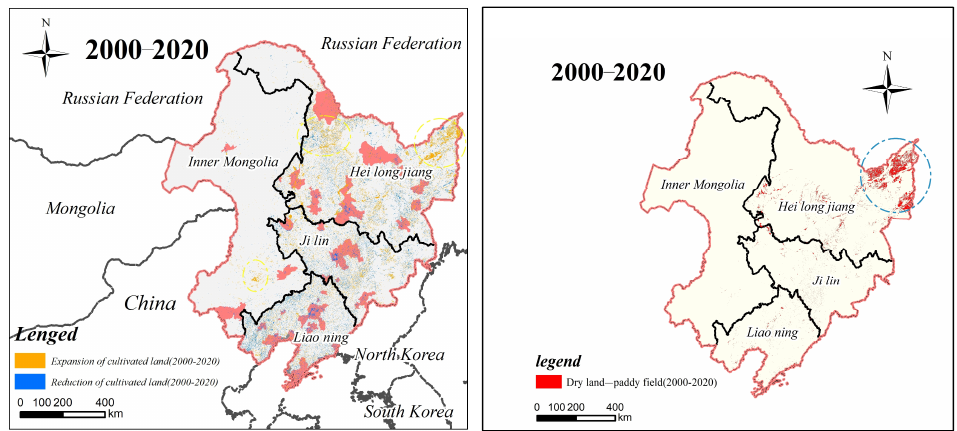
Figure 4. Changes of cultivated spatial land pa tt ern.